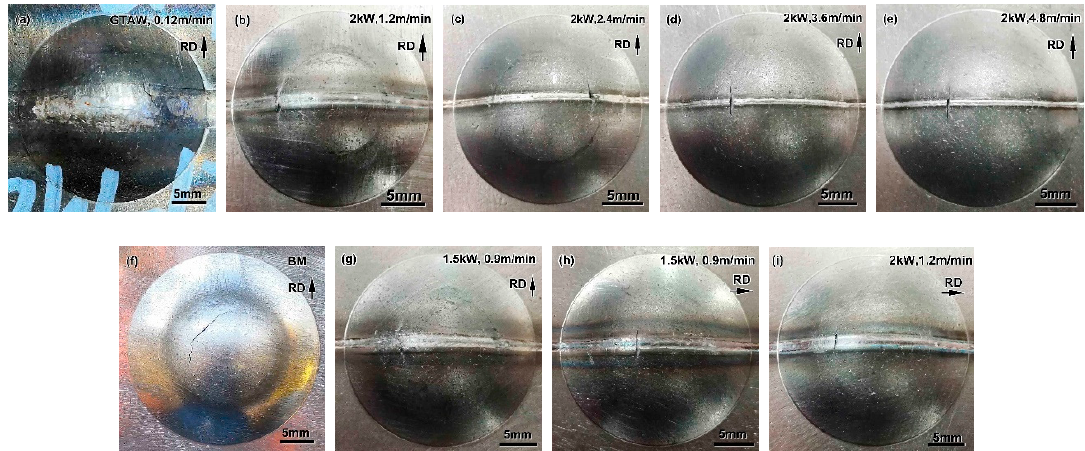
Figure 10. The top views of the cupping specimens that were tested, ( a ) GTAW welded joint, ( b – e ) and ( g ) laser welded joint with welding perpendicular to the rolling direction (RD), ( f ) base metal, ( h ) and ( i ) laser welded joint with welding parallel to RD.